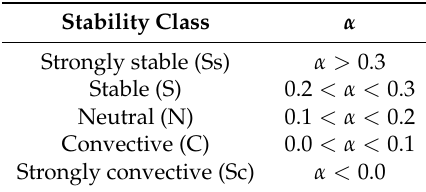
Table 3. Wind shear exponent stability classification